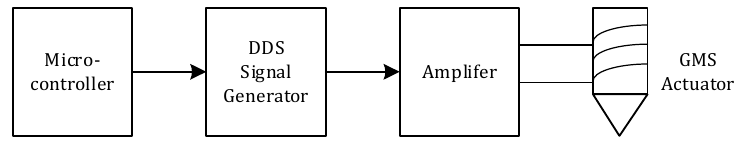
Figure 4. Principle of the sine sweep signal generator.